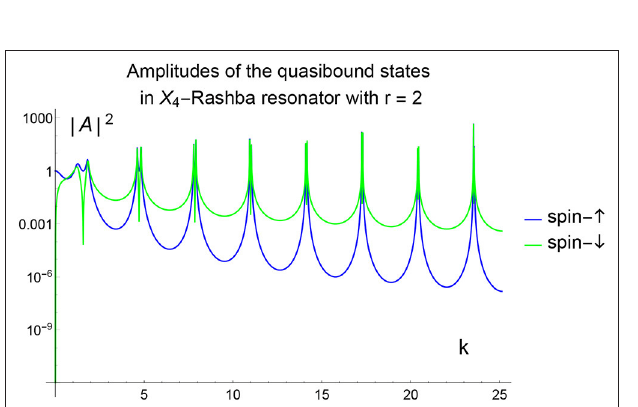
results of calculation of the resonant (quasilocalized) states (see with increasing the energy of incident particle. Of course this Figure 5 ). Second is the filter (see Figure 6 ) with scattering directly follows from the boundary conditions (19) and (22) since the effects depend on both r and the momentum. Figure 4 generating the spin- state from incident spin- state is shown represents the spin-flip effect for X 1 -resonator. Using such device ↓ ↑ it is possible to create the resonant (quasibound) states in the even at small values of r -coupling can reach high probabilities area between the wall and the defect (see Figure 5 ) for X 4